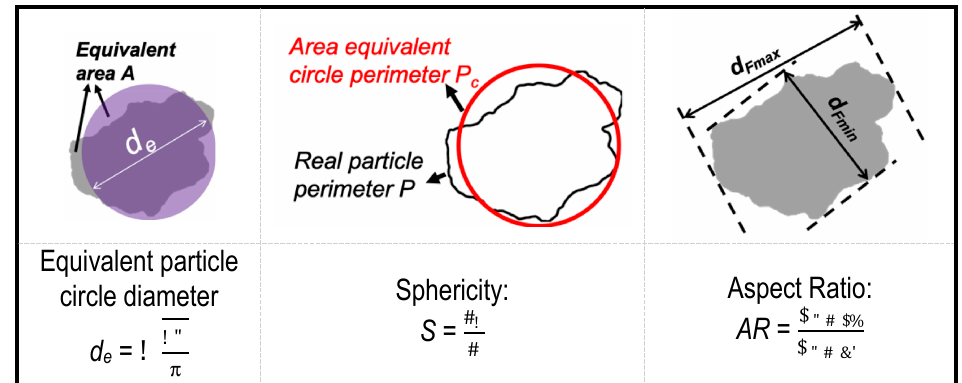
Figure 2. Graphical explanation of particle size and shape descriptors.